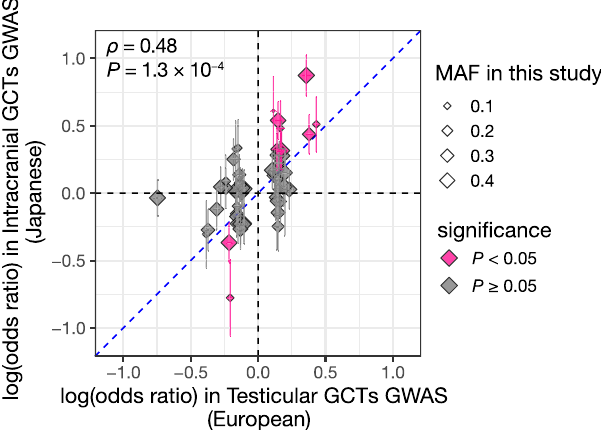
Fig.4|ComparisonofthegeneticriskofintracranialGCTsandtesticularGCTs. Effect sizes in the previous TGCTs GWAS are compared with those in the IGCTs GWAS. Each marker represents a risk locus derived from the TGCTs GWAS. Effect size and S.E. are shown. The blue dashed line is the identity line. Marker sizes are proportionaltoMAFinthisstudy.Pinkmarkersindicatethe11locimeetingnominal signi fi cance( P <0.05)intheIGCTsGWAS.The P valueisprovidedbythetwo-sided Spearman ’ s rank correlation